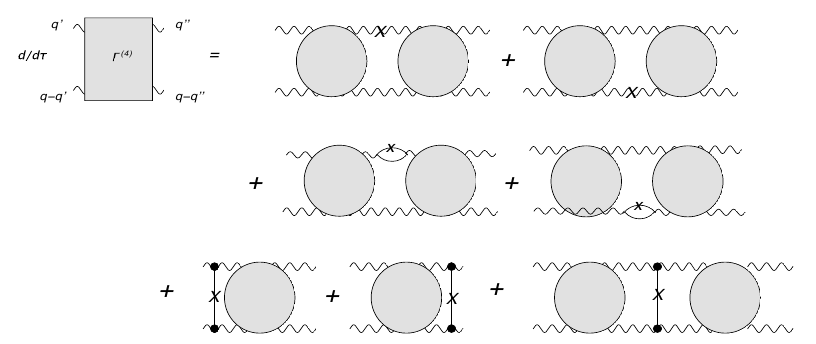
Figure 18 . Closing the 6-point function.